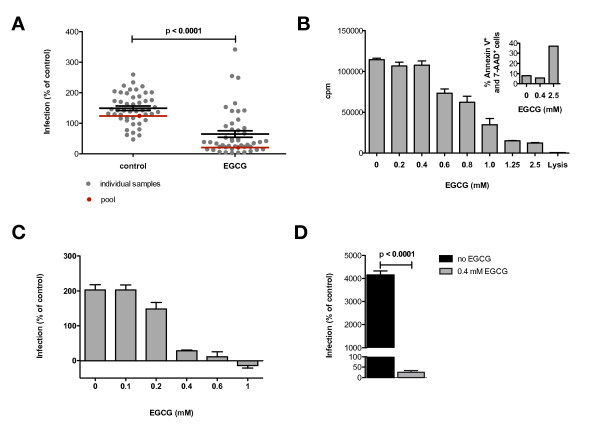
EGCG abrogates semen-enhanced viral infection and the effect of synthetic SEVI at nontoxic concentrations. A) 47 individual semen samples were preincubated separately and pooled in presence or absence of 0.4 mM EGCG and subjected to the infection assay as described in the methods section. Semen was used in a 1:16 dilution during preincubation. The Y-axis denotes the infection rate as percent in relation to control infections performed without semen. Data points represent mean values of quintuplicate infections, black lines show the mean values for all samples and standard error of the means. Red lines show the results for pooled semen. The indicated p-value is the result of a paired, two-tailed Student's t-test analysis. B) Cellular viability in presence of EGCG was tested in a [3H]-thymidin incorporation assay. Data is expressed as counts per minute, shown are mean values of quintuplicate measurements. Error bars represent the standard error of the means. The insertion figure shows the results of a flow cytometry-based apoptosis/necrosis assay utilizing Annexin-V and 7-AAD. The Y-axis denotes the percentage of Annexin V+, 7-AAD+ and double positive cells. C) A random individual semen sample was subjected to the infection assay as described above in presence of increasing EGCG concentrations. D) Synthetic SEVI (250 μg/ml) in presence or absence of 0.4 mM EGCG was subjected to the infection assay as described above. The indicated p-value is the result of a paired, two-tailed Student's t-test analysis.